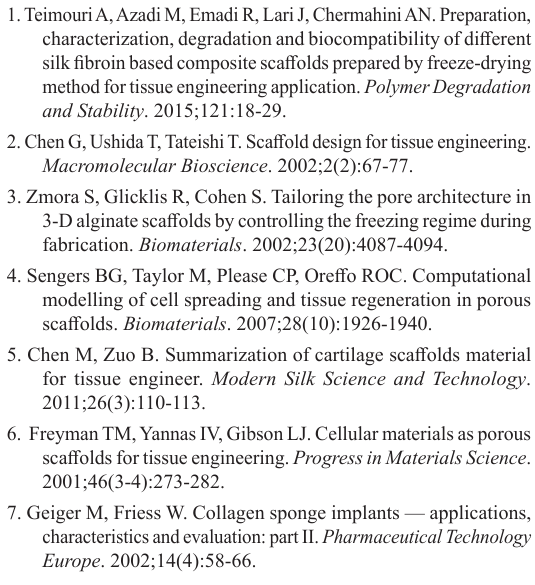
Figure 4: Surface (left) and cross-section (right) images of scaffolds frozen at -27°C (a, b) and -190°C (c,d) measured by SEM. triple-helix chains in the presence of chitosan.